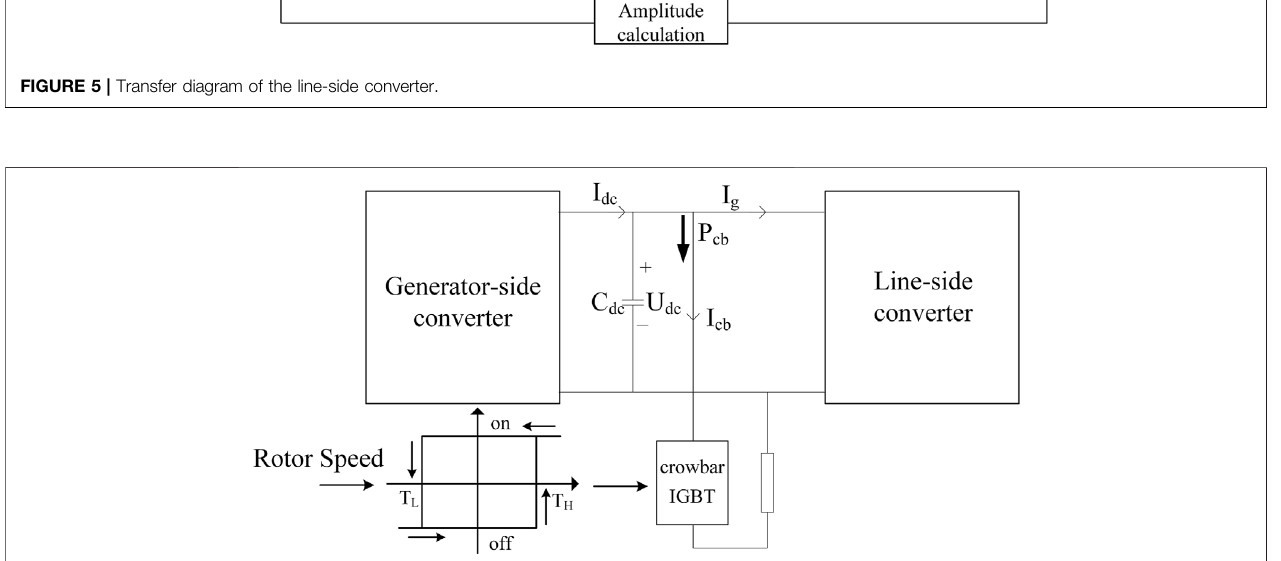
FIGURE 6 | Control strategy of the crowbar circuit.